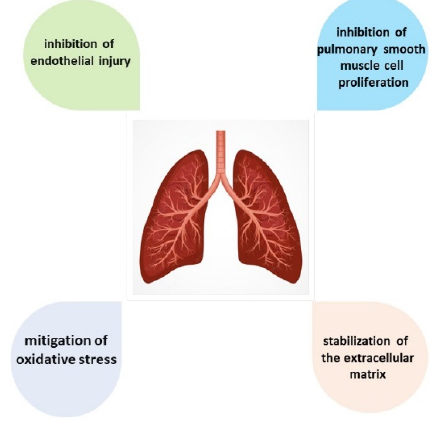
Figure 3. The baicalin action in the pulmonary system.